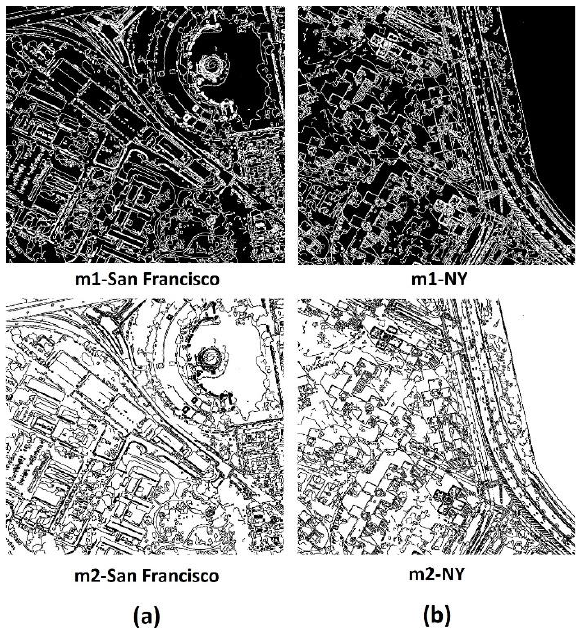
Figure 10. Masks of details area (m 1 ) and flat area (m 2 ): (a) San